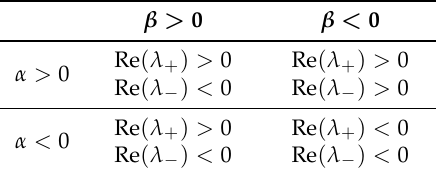
Table 1. Real parts of the eigenvalues of the Jacobian as a function of α and β . λ + refers to the addition of the square root, while λ − refers to the subtraction of the square root in Equation